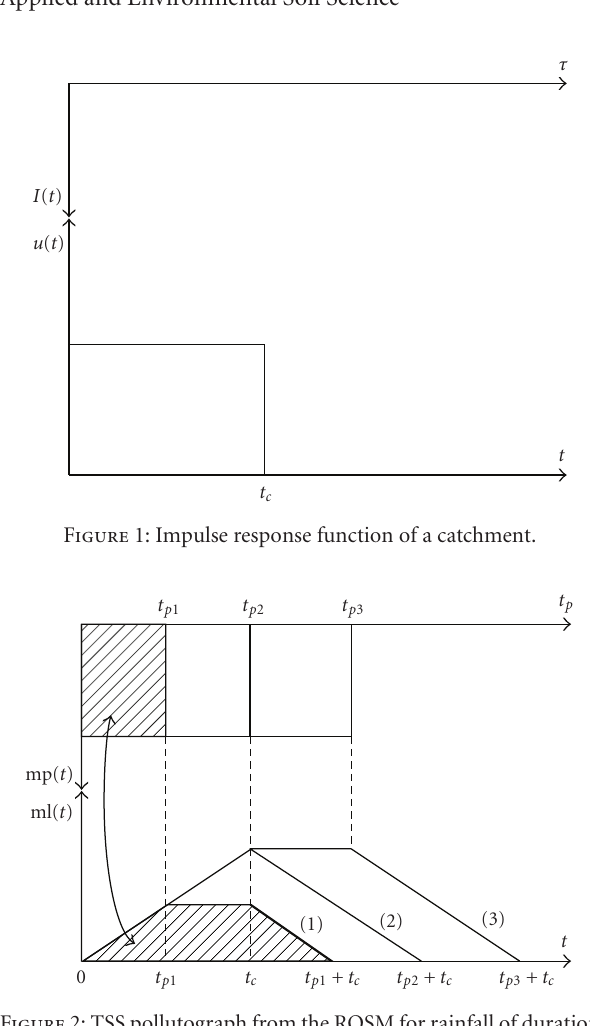
Figure 2: TSS pollutograph from the RQSM for rainfall of duration (1) t p < t c , (2) t p = t c , (3) t p > t c .